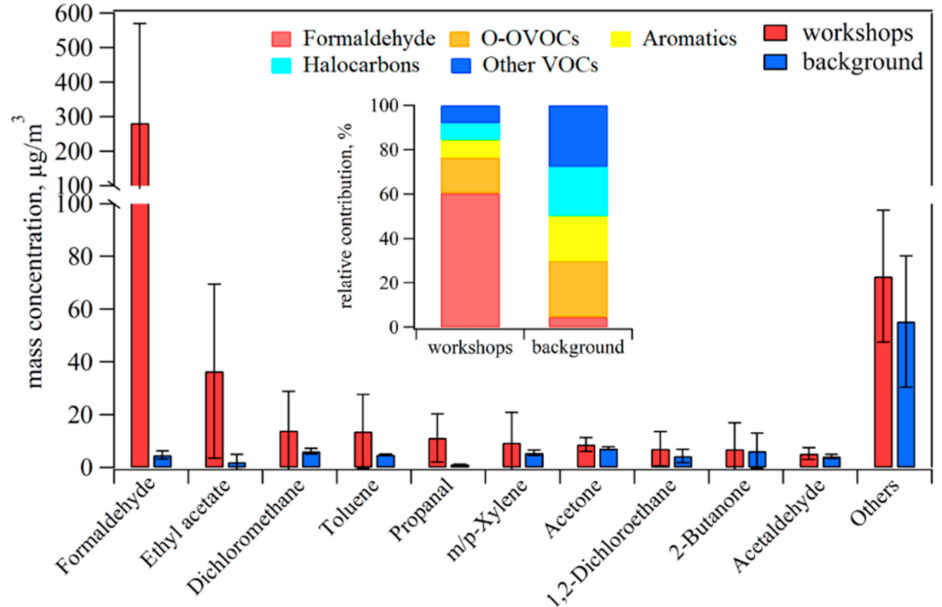
Figure 2. Average mass concentrations and chemical composition of VOCs in workshops of the plywood manufacturing industry (red bar) and background ambient air (blue bar). The errors bars indicate the standard